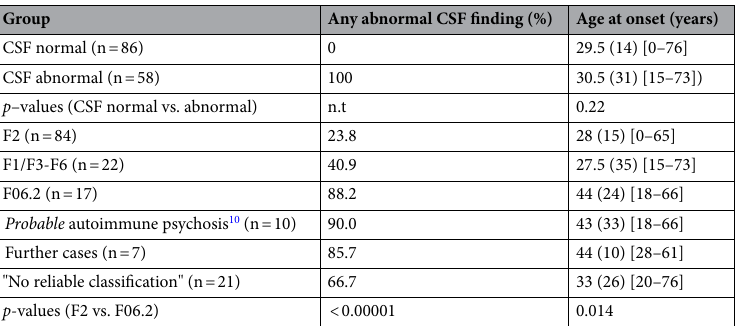
Table 1. Prevalence of abnormal CSF findings and age at onset of psychotic symptoms. Any abnormal CSF finding is presented as prevalence percentage and being a nominal variable tested by chi-square test. Age at onset is presented as median (interquartile range) [range (minimum–maximum value)] tested by the Shapiro– Wilk test being a non-Gaussian-distributed variable. Only corrected p-values (two tests, Bonferroni) are reported. For group comparisons of age at onset, the Kruskal–Wallis-test was used. The posthoc analysis is presented in the results section. Abbreviation: n.t. = not tested.